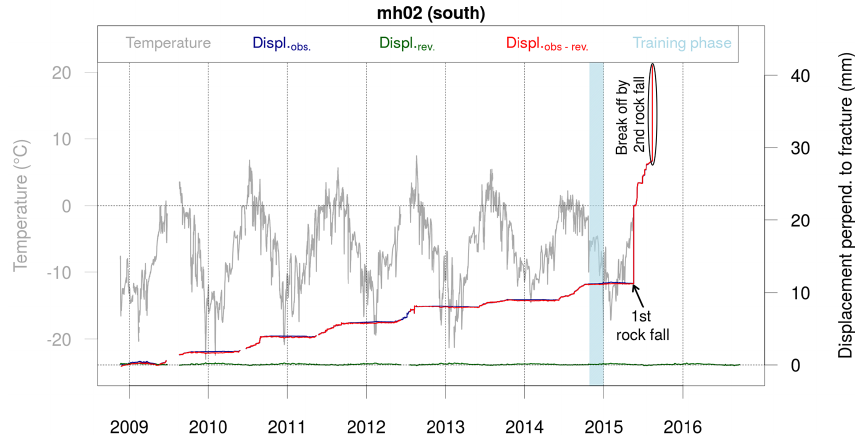
Figure 11. Linear regression model (LRM; green) applied to the observed displacements (blue) perpendicular to the fracture at location mh02 . The reversible component (green) due to thermoelastic strains in rock can be modeled by a LRM with temperature as input data (dark gray) and displacement measurements during a training period of several months (light blue shading). Subtracting these reversible displacements from the observed data results in the red line, referred to as irreversible fracture